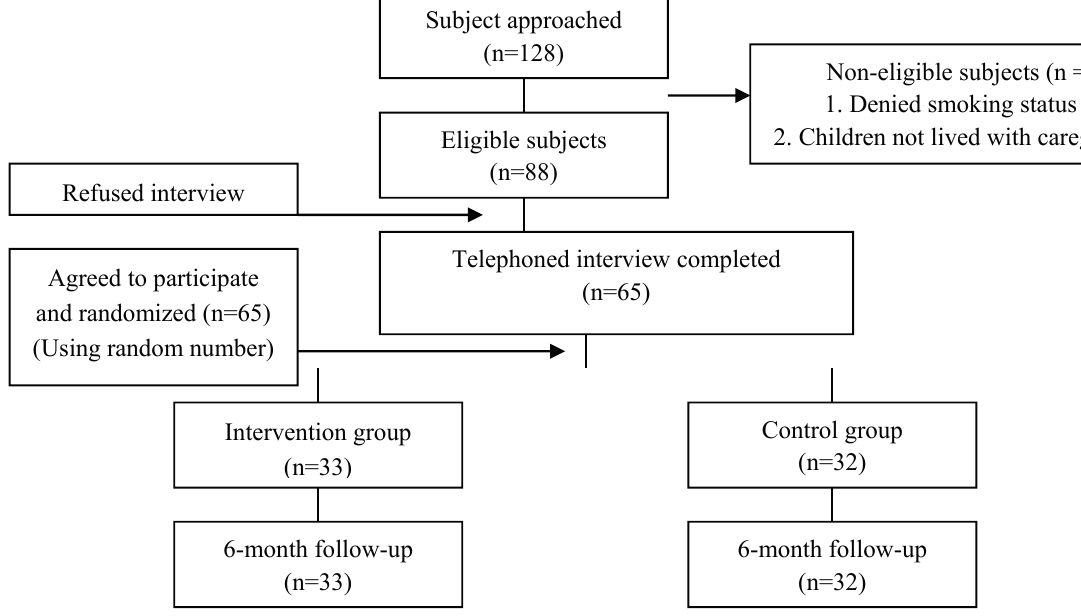
Figure 1. Diagram showing the selection process of